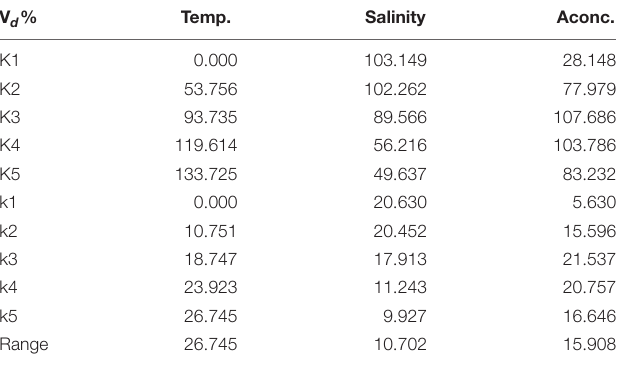
TABLE 5 | NaOH V d % orthogonal data processing. V d % Temp.